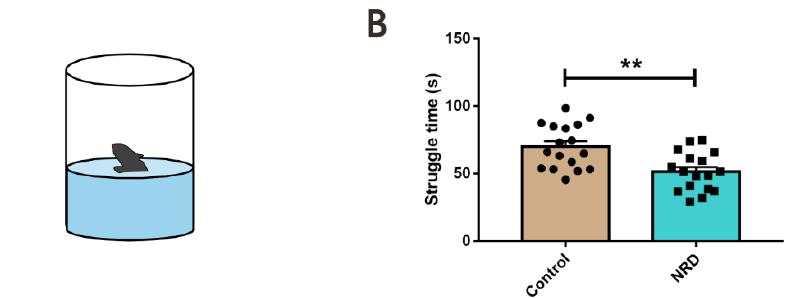
Figure 4. Decreased struggle time in NRD mice. ( A ) Diagram of the forced swim test. ( B ) Struggle times of the control and NRD mice in the forced swim test. ** p < 0.01 as determined by unpaired Student’s t -test. Data are expressed as the means ± SEMs. n (control) = 17, n (NRD) = 17.